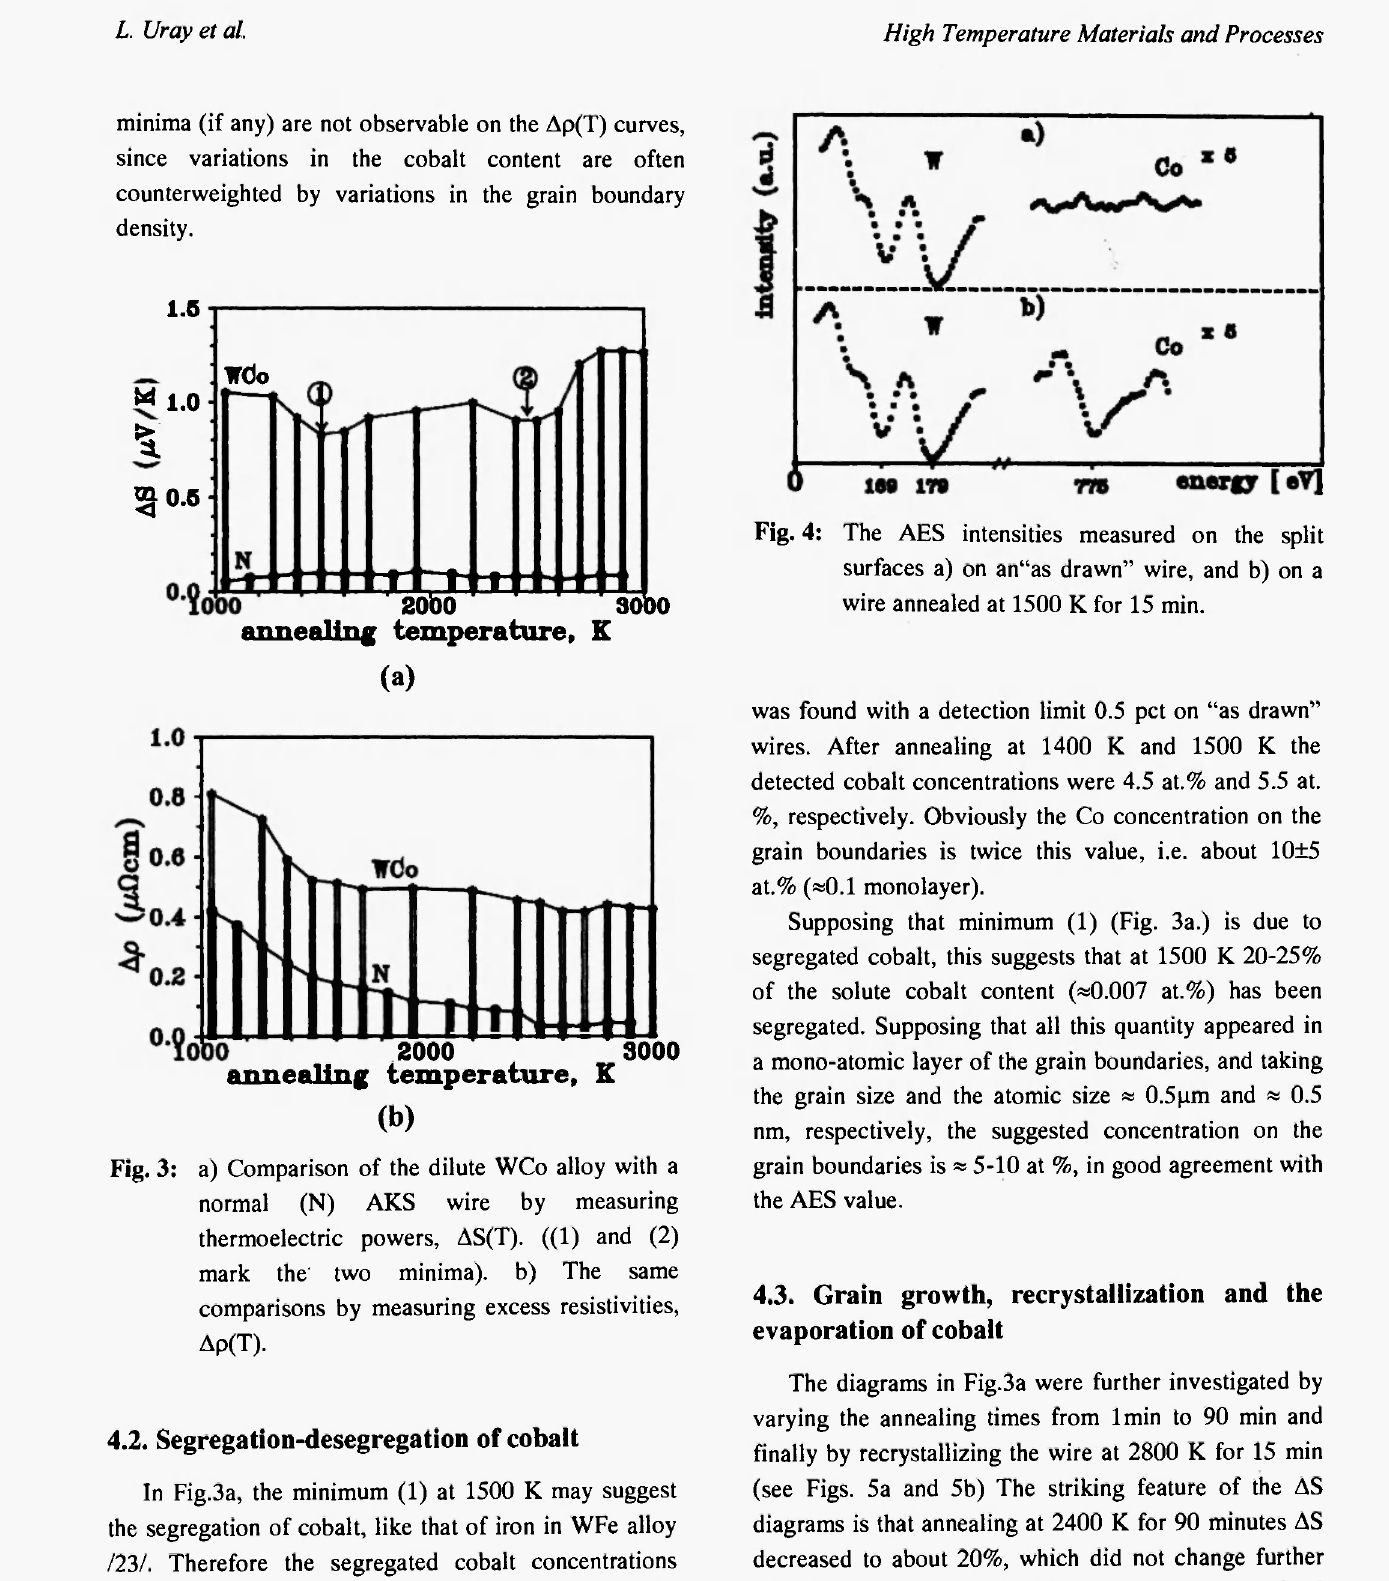
Fig. 3: a) Comparison of the dilute WCo alloy with a normal (N) AKS wire by measuring thermoelectric powers, AS(T). ((1) and (2) mark the two minima), b) The same comparisons by measuring excess resistivities, Δρ (Τ).